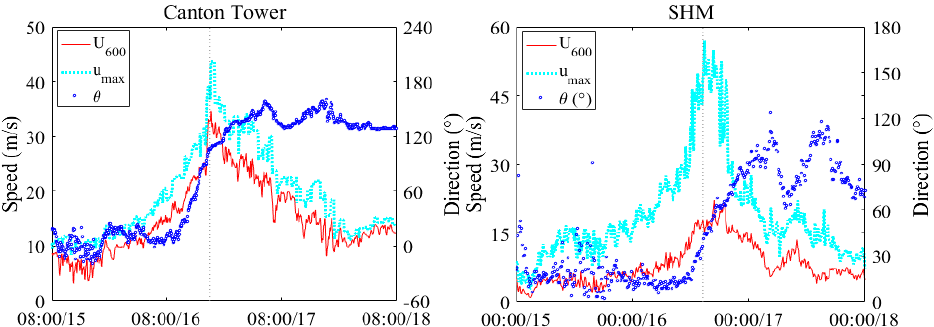
Figure 5. Time histories of wind measurements at two sites (the vertical gray dot line denotes time constant of 17:00 on 16 September 2018 when Mangkhut got closest to the study site).